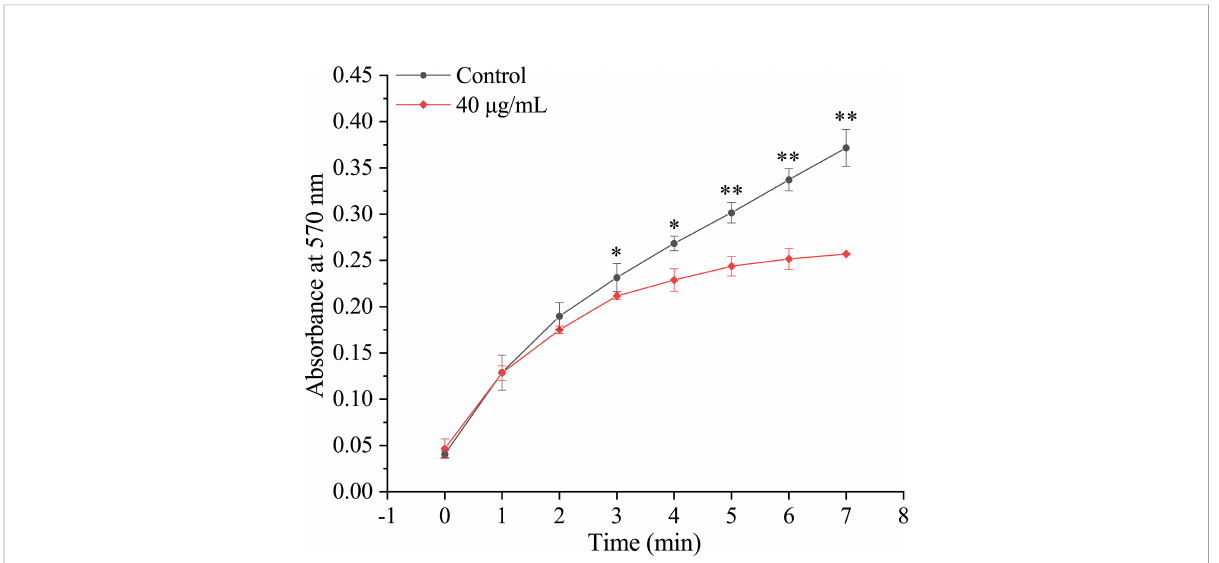
FIGURE 7 Effect of rPmTyr-4 on the precipitation rate of calcium carbonate. ● : 40 m g/mL MBP as control; ◆ : 40 m g/mL rPmTyr-4. * indicates signi fi cant difference by T-test ( P<0.05 ). ** indicates extremely signi fi cant difference by T-test ( P<0.01 ). Error bars correspond to mean ± SD.